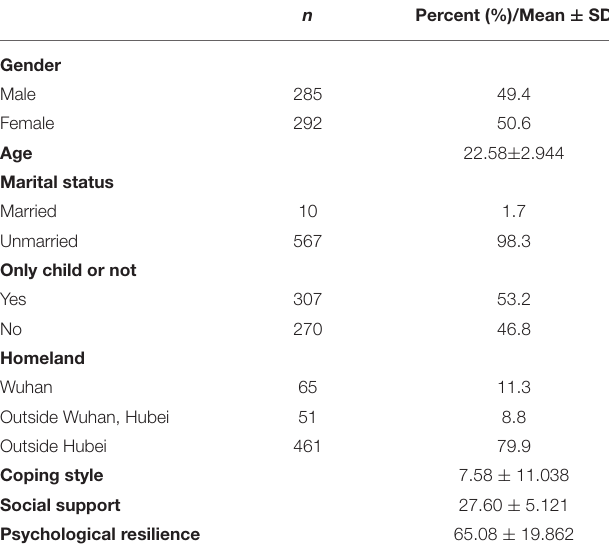
TABLE 1 | Sample characteristics and primary variables ( N =